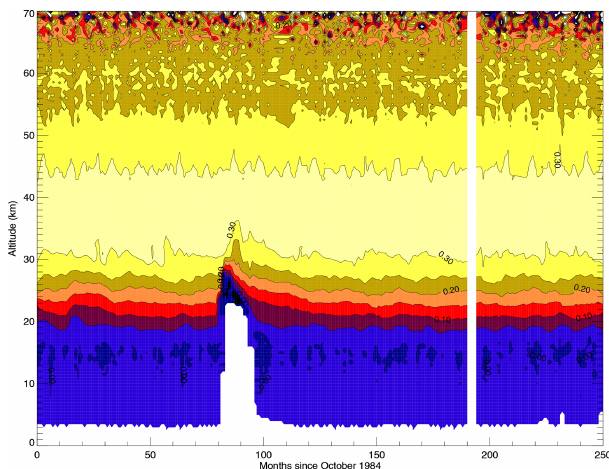
Figure 5. Measurement fraction, f , for 5 ◦ N for all SAGE II data (no clearing) for the entire lifetime of the instrument. Note that the Mount Pinatubo period, particularly from month 81 (June 1991) to through to roughly month 100 (the end of 1992), shows a clear re- duction of the value of f above 18km to as high as 35km. Though several other volcanic events occur during the SAGE II lifetime (e.g. Nevado del Ruiz and Nyamuragira), none of these are readily appar- ent in f since they were an order of magnitude or more smaller than the Mount Pinatubo